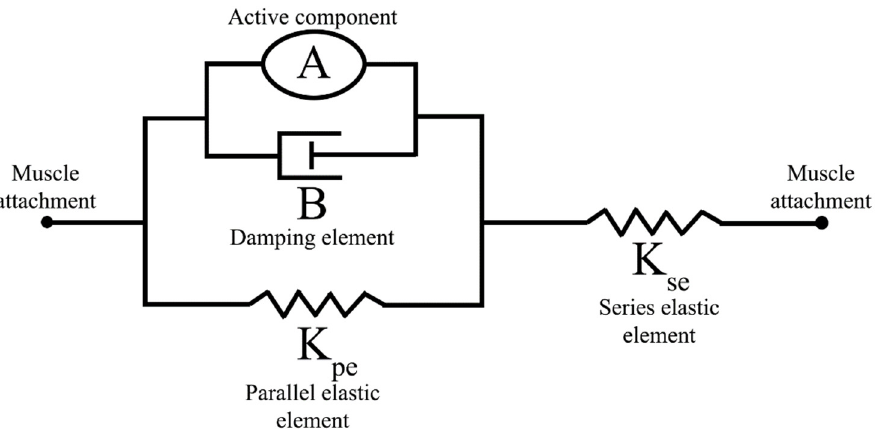
Figure 2. The linear Hill muscle model is implemented in the hindlimb. The spring-damper system replicates the passive and active structures of muscle with three passive viscoelastic components ( K se , K pe , B ) and one active component ( A ).